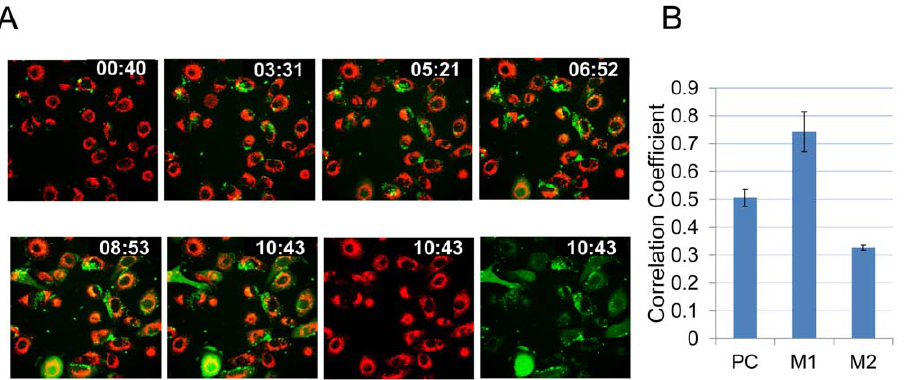
Figure 1. Live cell imaging of Rg-RSV-infected cells. ( A ). A549 cells were seeded in 35 mm glass-bottom fluorodishes (Fisher Scientific) and stained with CMXRos, live mitochondrial labeling kit (Molecular Probes) for 15 min at 37 u C, washed and then fresh medium (DMEM with 2% FBS) was added to the cells. Cells were infected with rgRSV at MOI of 1 and visualized on a Perkin Elmer UltraVIEW H VoX 3D Live Cell Imaging System equipped with a Nikon T inverted microscope. The cells were maintained at 37 u C with 5% CO 2 throughout the imaging (16 h post-infection). Images were taken at 0:40, 3:31, 5:21, 6:52, 8:53, and 10:43 hours post-infection. The last two images in the bottom panel show mitochondrial staining and GFP alone respectively at 10:43 h p.i. The colocalization of GFP (green) with mitochondria (red) is shown as yellow. ( B ). The Pearson’s and Manders’ overlap coefficients are represented as the average of ten individual cells at 10:43 hp.i.